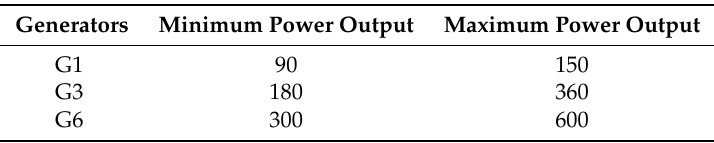
Table 2. Operation Range of Generators (MW).